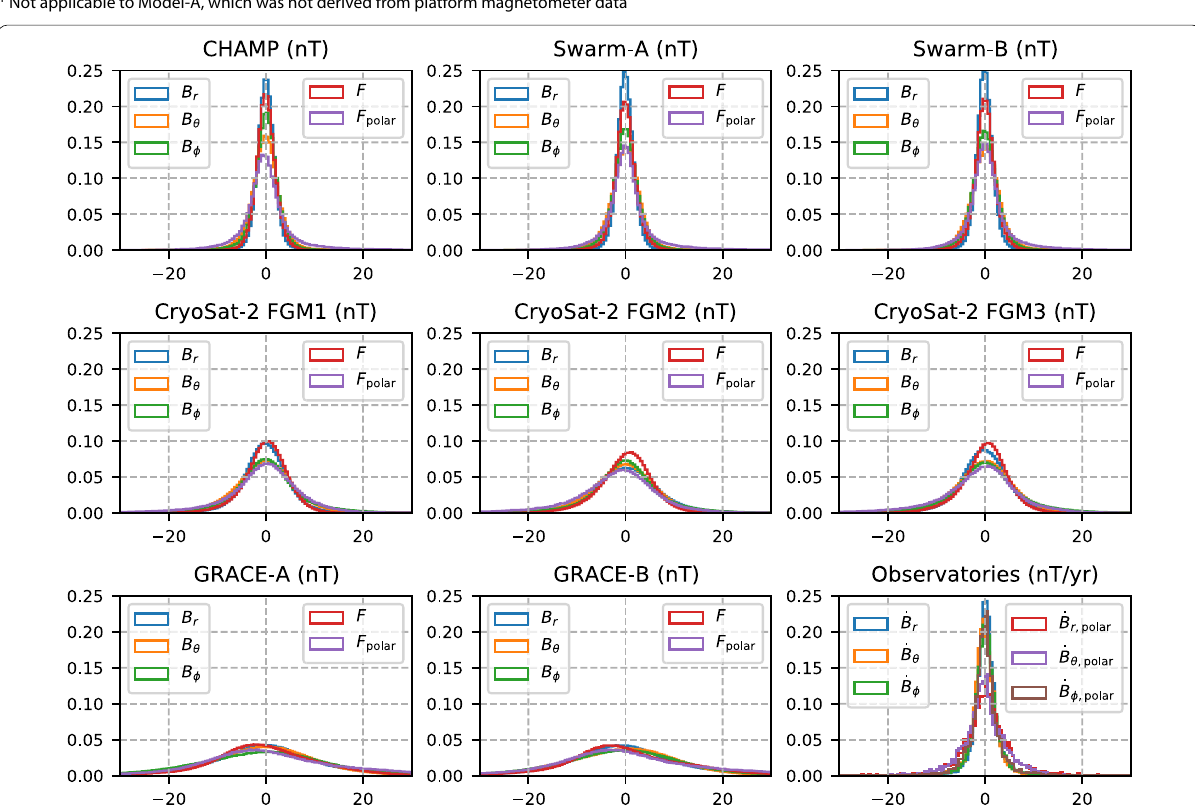
Fig. 3 Histograms of the residuals of each satellite and ground observatory SV data using Model-B. The histograms have been normalized to have unit area. Computed statistics are shown in Table 5 for the satellite data and Table 6 for the ground observatory SV data